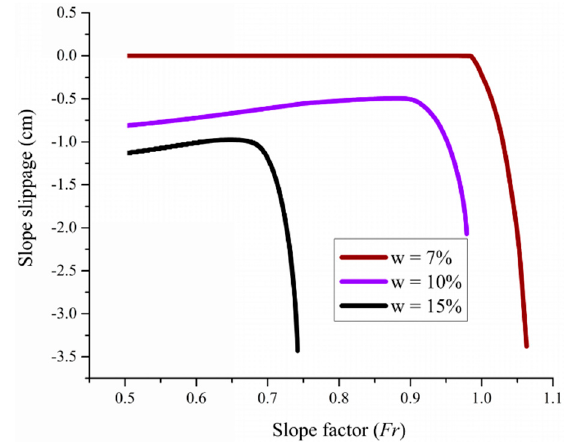
Figure 4. Trend graph of slope safety factor Fr with initial moisture content w.